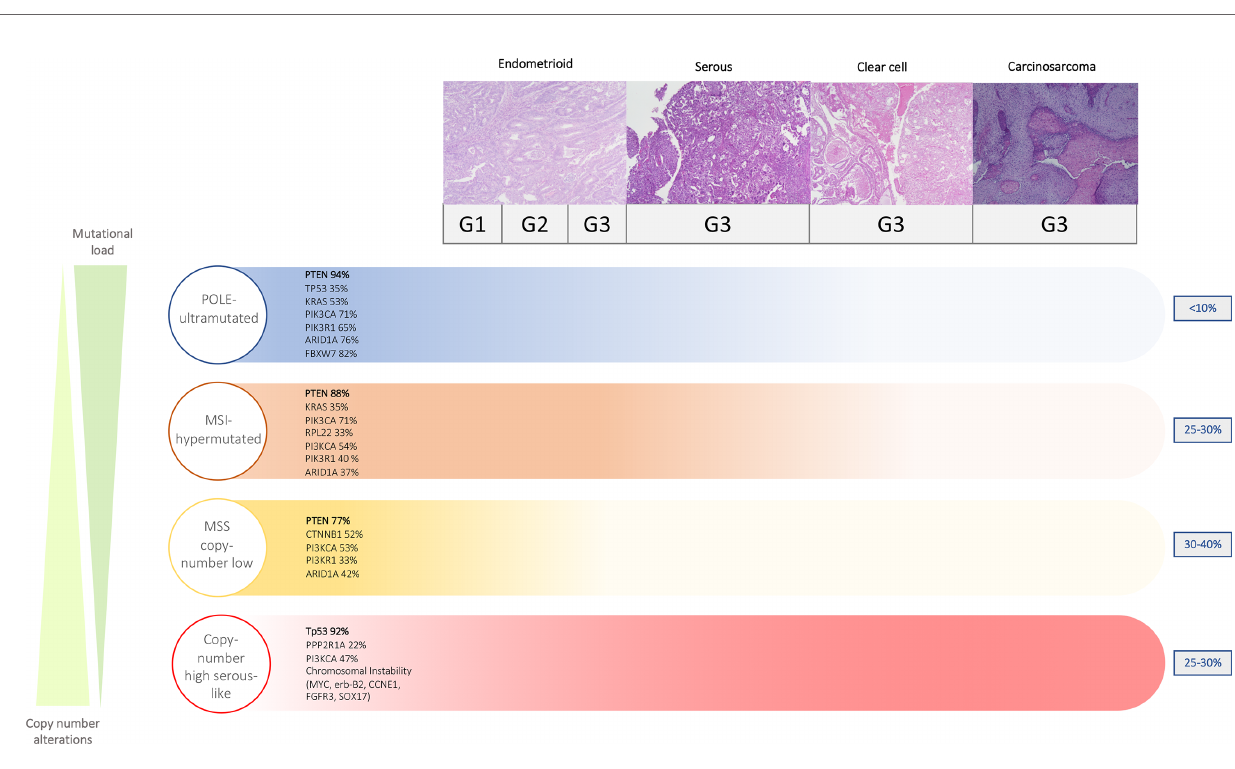
FIGURE 1 | Distribution of molecular features across different EC